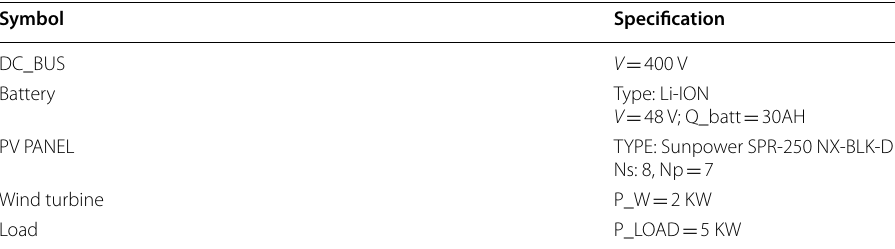
Table 8 Small hybrid wind–solar battery technical